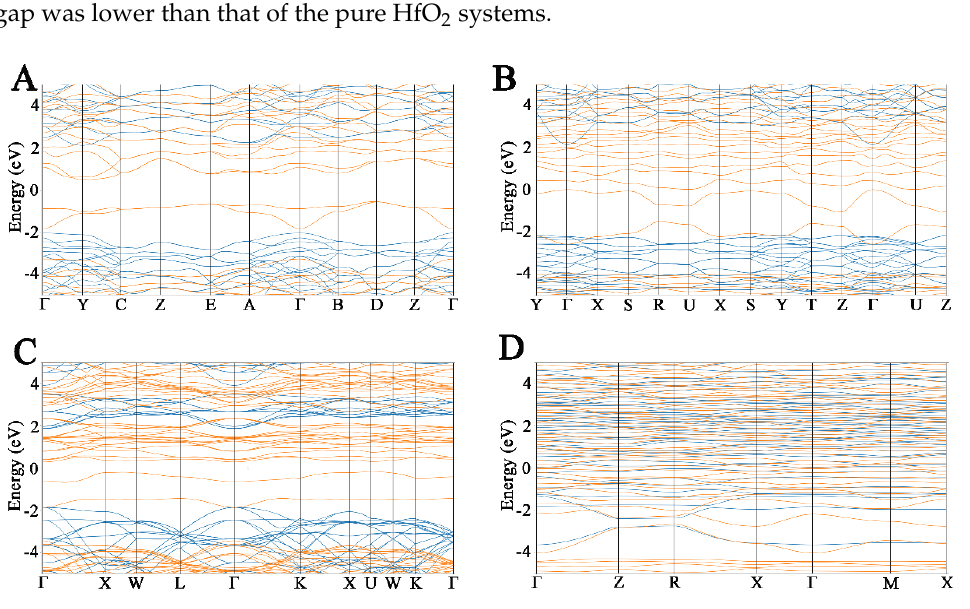
Figure 8. Bandgap structures of m- ( A ), o- ( B ), c- ( C ), and t- ( D ) HfO 2 . The blue lines highlight the bands of models with no defect, while orange lines outline the bands of defected HfO 2 polymorphs.